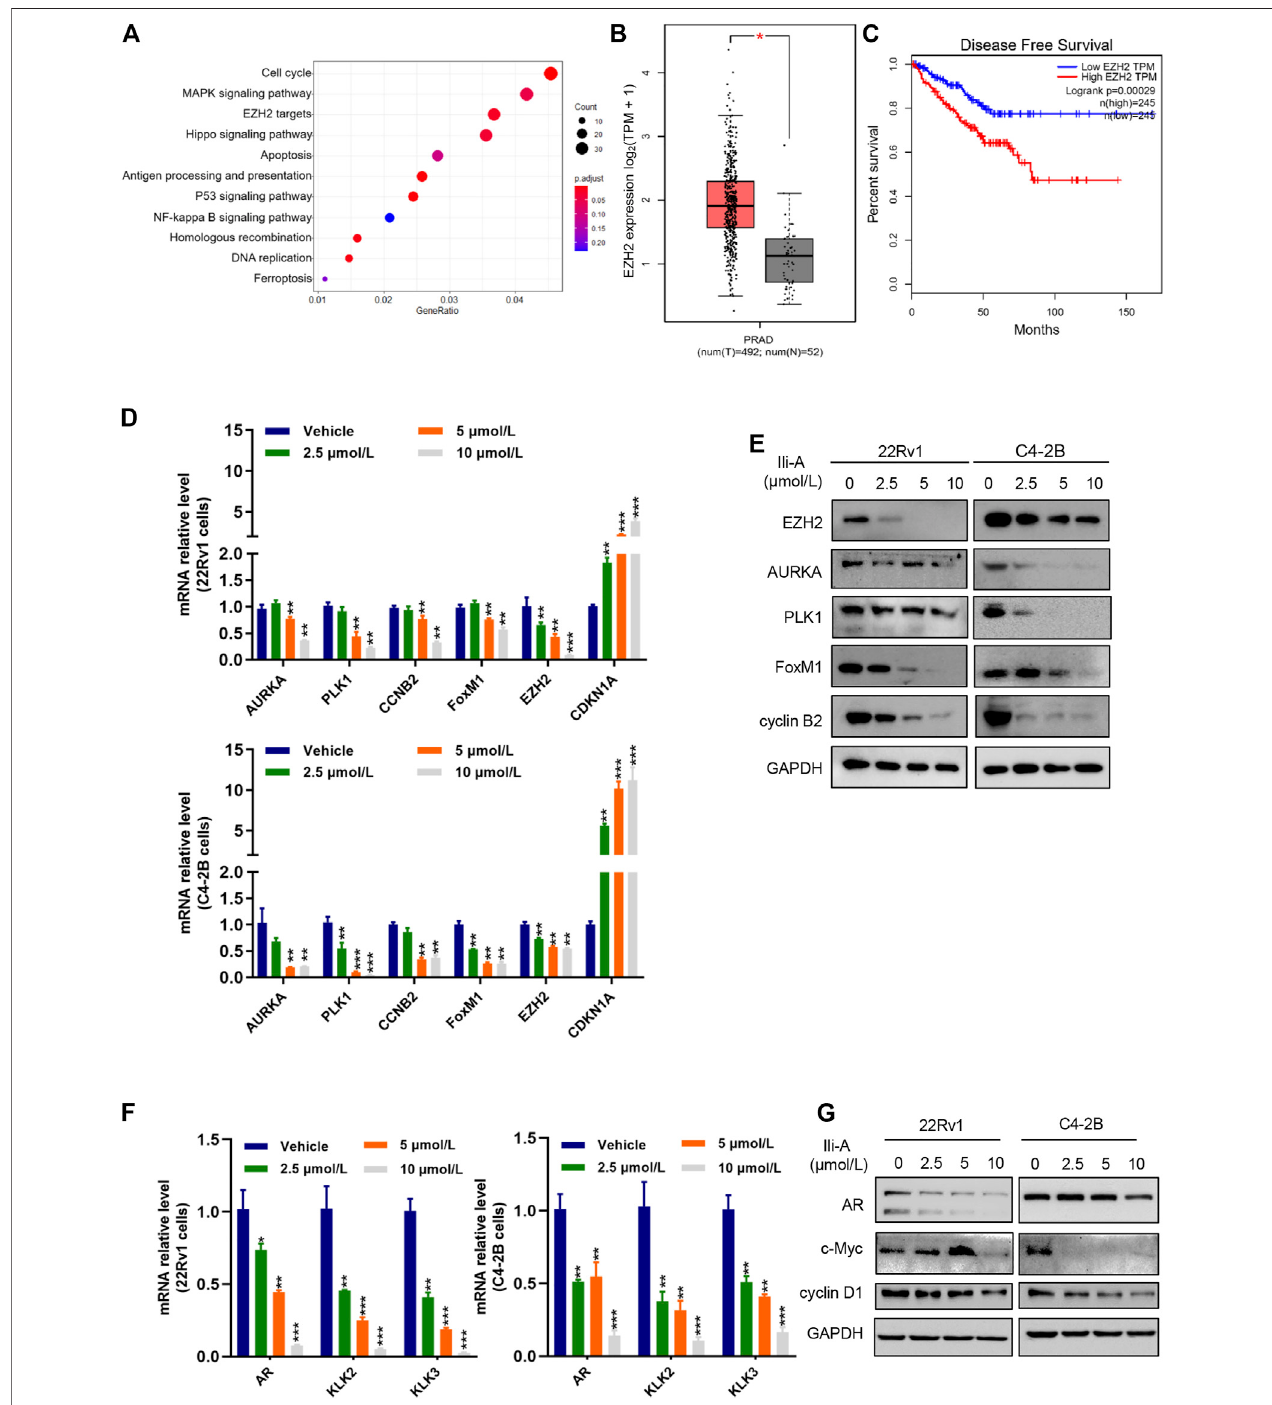
FIGURE 2 | RNA-sequencing shows that the EZH2 pathway is involved in the proliferation of prostate cancer cells. (A) Bubble chart showing enrichment of the most signi fi cantly changed genes in the signaling pathways of C4-2B cells. (B) Gene expression of EZH2 expression in human prostate cancer in TCGA and matched normal prostate-gland tissues in TCGA using log2 (TPM +1) for log scale. (C) EZH2 mRNA expression was correlated inversely with survival from prostate cancer. Kaplan – Meier plots are based on analyses of data from prostate-cancer patients in TCGA using GEPIA. (D) RT-qPCR showing expression of the indicated cyclin genesin22Rv1 cellsand C4-2B cellstreated withvehicleorIli-A for48 h. (E) Immunoblottingshowingexpression ofthe indicated cyclinproteins in22Rv1 cellsand C4- 2BcellstreatedwithvehicleorIli-Afor48 h. (F) RT-qPCRshowingexpressionoftheARdownstreamgenesin22Rv1cellsandC4-2BcellstreatedwithvehicleorIli-Afor 48 h. (G) Immunoblotting showing expression of AR downstream proteins in 22Rv1 cells and C4-2B cells treated with vehicle or Ili-A for 48 h.